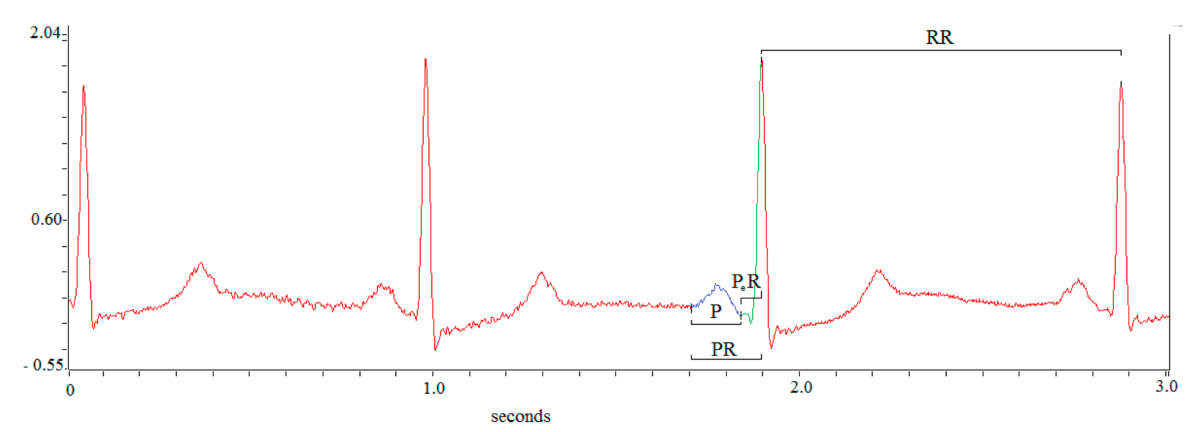
Figure 2. RR, P wave (the intervals between the start and end of P wave), PR (from the start of P wave to the peak of R wave) and P e R (between the end of P wave and the peak of R wave). The mean and standard deviation values were measured for each of these intervals and the spectral power expressed was analyzed in normalized (NU). NU were calculated as follows: Low Frequency R-R interval in normalized units (LFRRnu) = Low Frequency (LF) power/[Total Power (TP) − Very Low Frequency (VLF) power] × 100; High Frequency R-R interval (HFRRnu) = High Frequency (HF) power/(TP − VLF power) × 100 [22,25–27]. For RR and SBP, the total power (TP) was determined (TP), i.e., total spectral density (from 0 to 0.40 Hz) as well as the following spectral components: a high-frequency (HF) (from 0.15 to 0.4 Hz Eq), a low-frequency (LF) component (from 0.04 to 0.15 Hz Eq) and a very-low-frequency (VLF) component (below 0.04 Hz Eq) [25–27]. The spontaneous baroreflex sensitivity was calculated with the alpha ( α ) index. This method yields two √ √ √ √ α indexes: α LF ( RR LF: SBP LF) and α HF ( RR HF: SBP HF) [28,29].